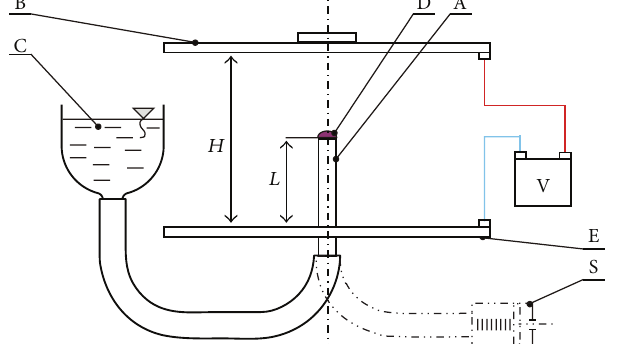
Figure 3: The scheme of Taylor’s two-plate apparatus [15]: A, metal tube electrode; B, counter plate electrode; C, polymer supplied from a reservoir through flexible tube; D, polymeric droplet; E, plate; S, polymer supplied by a graduated syringe (alternative option for measuring the rate or